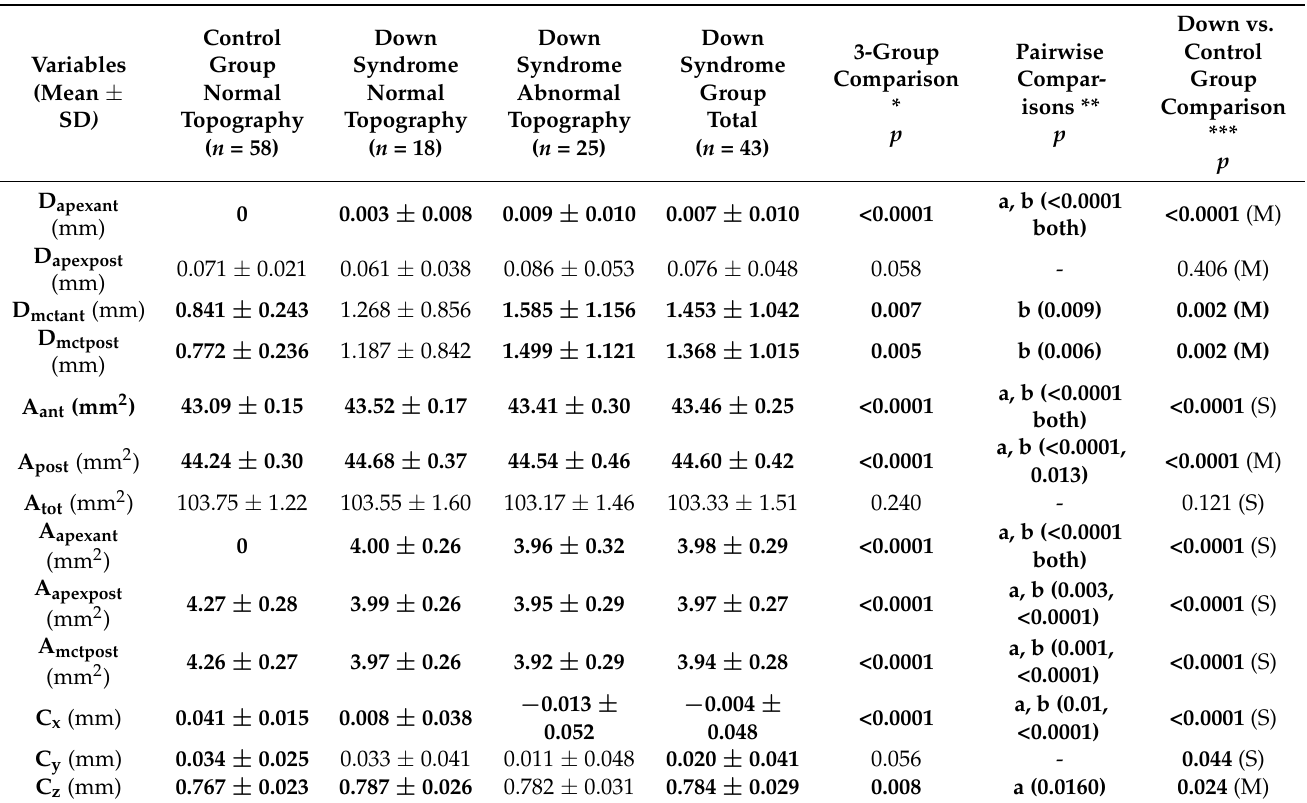
Table 2. Comparison of the corneal morphogeometric parameters between the control and Down syndrome groups.